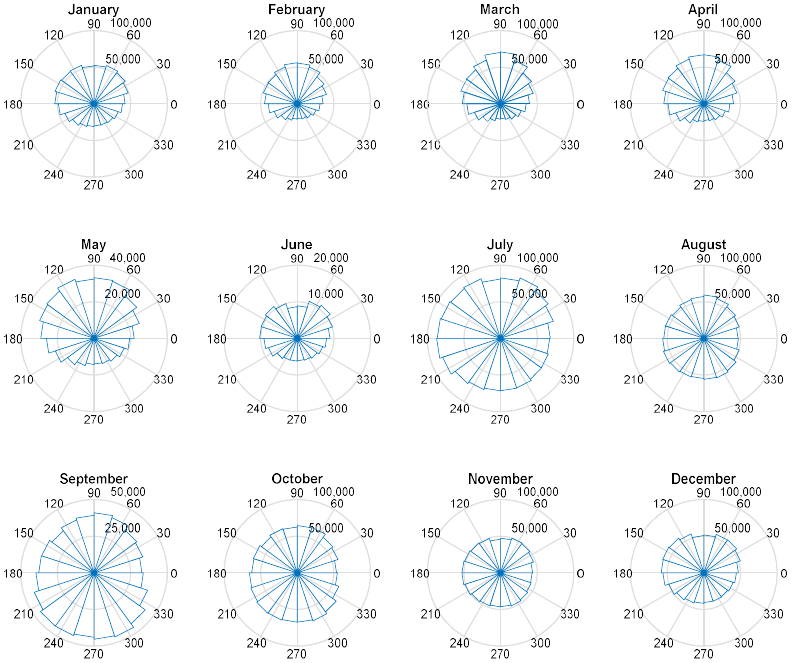
Figure 10. Azimuthal distributions of total meteor detections for every composite day in each calendar month at 15° azimuthal angle intervals over Langfang, China (39.4° N, 116.7° E), from 1 July 2010 to 31 July 2011.